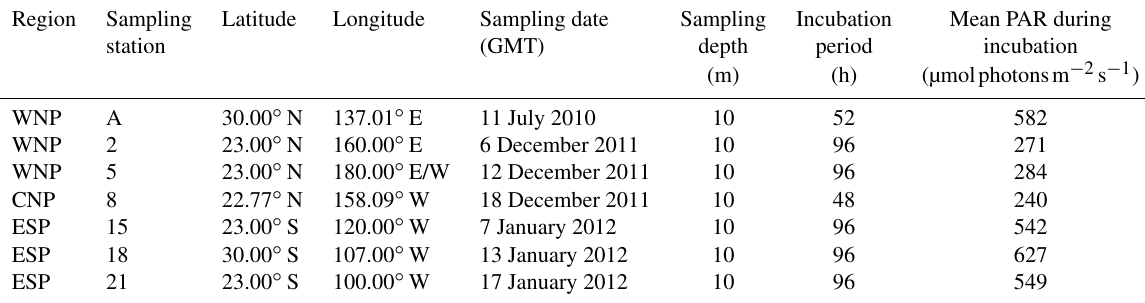
Table 1. Details of the incubation experiments. Region Sampling Latitude